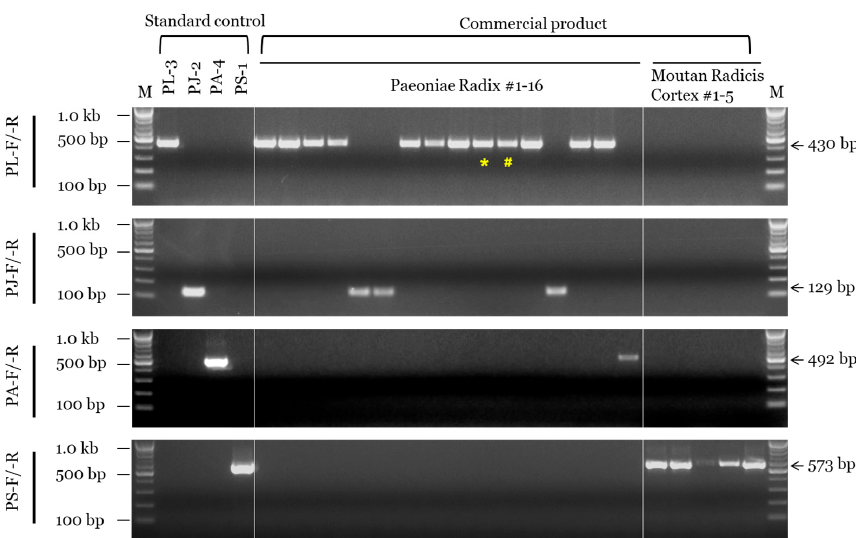
Figure 4. SCAR assay of PR and MRC samples sold in the Korean herbal market. SCAR primer combinations (PL-F/-R, PJ-F/-R, PA-F/-R, and PS-F/-R) and 100 bp, 500 bp, and 1.0 kb bands of the 100 bp DNA marker (M) are indicated on the left. List information is provided in Table S1 and Table 3. Arrows and numbers on the right indicate amplicon size. Special characters (* and #) indicate inconsistencies between the results of morphological and genetic assays. 3. Discussion Herbal medicines can be easily mislabeled for economic gain economic because au- thentic species and adulterants are morphologically similar and have similar names [12,13]. In traditional Korean medicine, P. lactiflora is considered an authentic herbal med- icine (PR) species, together with P. japonica and P. anomala subsp. veitchii [1,3,4]. However, because of economic motivation, P. lactiflora is sometimes traded as P. japonica , which is more expensive than the other Paeonia species in the Korean herbal market [4]. PRA, the peeled root of P. lactiflora , is called Baek-jak in Korean, which is synonymous with Baek-jak- yak , a herbal medicine derived from P. japonica [4]. Therefore, PRA could possibly be mis- labeled as P. japonica [4]. Moreover, the herbal medicines PR and MRC are distributed in processed forms such as slices and dried roots, which makes it difficult to identify the plant species based on morphological evaluation [4]. Therefore, highly trained profession- als, such as herbologists and taxonomists, are needed for the accurate morphological iden- tification of species [3]. In recent studies, artificial intelligence using the deep-learning model has been employed for the morphological discrimination among species; however, this platform is not yet complete and therefore not reliable [17]. Recently, pharmacological analyses have been conducted to identify the effective components of Paeonia species [7,10,11]. Shi et al. reported that P. lactiflora and P. anomala subsp. veitchii contain more monoterpenoids than other Paeonia species [5]. Monoterpe- noids, the main bioactive compounds unique to Paeonia species, possess anti-inflamma- tory, antioxidant, anticoagulative, antiallergic, sedative, and analgesic properties [18,19]. Ko et al. reported that P. japonica contains many bioactive compounds such as albiflorin, paeoniflorigenone, oxybenzoyl-paeoniflorin, paeonol, and paeoniflorin [10]. Therefore, we may discover new natural compounds with excellent pharmacological properties among these bioactive constituents. The importance of diagnostic assay development was realized in Korea in 2015 dur- ing a confusing market situation called the Baek-suo situation. Cynanchum wilfordii , an au- thentic component of Cynanchi Wilfordii Radix, was used to synthesize dietary supple-